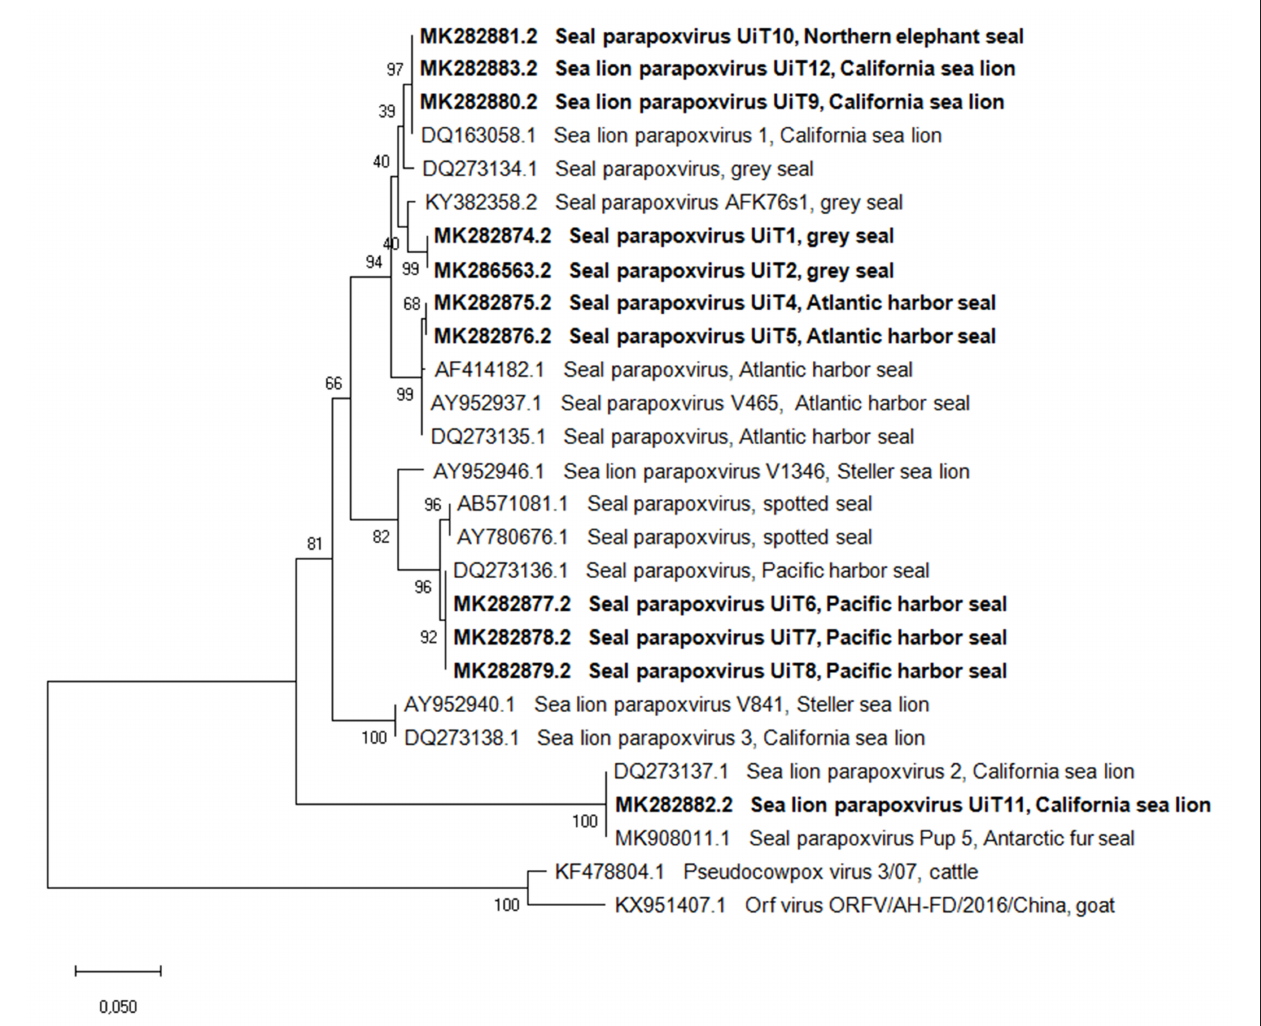
FIGURE 2 | Phylogenetic tree based on the partial nucleotide sequences of the B2L gene obtained in this study compared with corresponding DNA sequences from parapoxviruses published in GenBank. Isolates are described by GenBank accession number, parapoxvirus species and host species. The phylogenetic tree was constructed using the maximum-likehood method based on the calculation of the genetic distances between pairs of sequences using the Tamura 3-parameter model. The statistical support for the tree was provided by 1,000 bootstrap replicates with the respective percentages indicated on the branches. The scale bar corresponds to 0.05 aa substitutions per site. Sequences obtained in this study are shown in